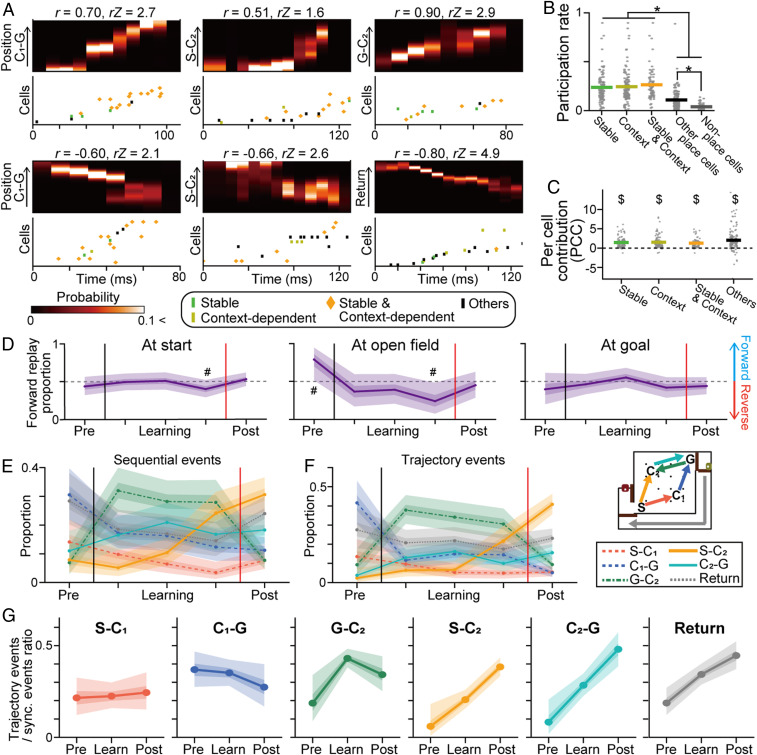
Representations by learning-dependent replay events. (A) Magnified views of the synchronous events shown in Fig. 3E and corresponding raster plots of the place cell spikes. The spikes are labeled based on cell type. (B) Participation rates of individual cells in synchronous events (n = 112, 116, 74, 154, and 47 cells). The gray dots represent each cell, and the colored lines represent the average: *P < 0.05, Tukey’s test. (C) PCC of individual cells to replay events: $P < 0.05, one-sample t test versus 0. (D) The directionalities of replay events in individual areas. The proportions and statistical significance were computed at each time point. For a visualization purpose, these different time points were connected. The thick and thin shaded areas indicate the 50% and 95% credible intervals, respectively. A pound sign (#) indicates that 0.5 is not in the 95% credible interval. (E and F) Learning-related changes in the proportions of the represented paths by replay events with sequential and trajectory events. (G) The proportion of synchronous events assigned as trajectory events for each path. The thick and thin shaded areas indicate the 50% and 95% credible intervals, respectively.